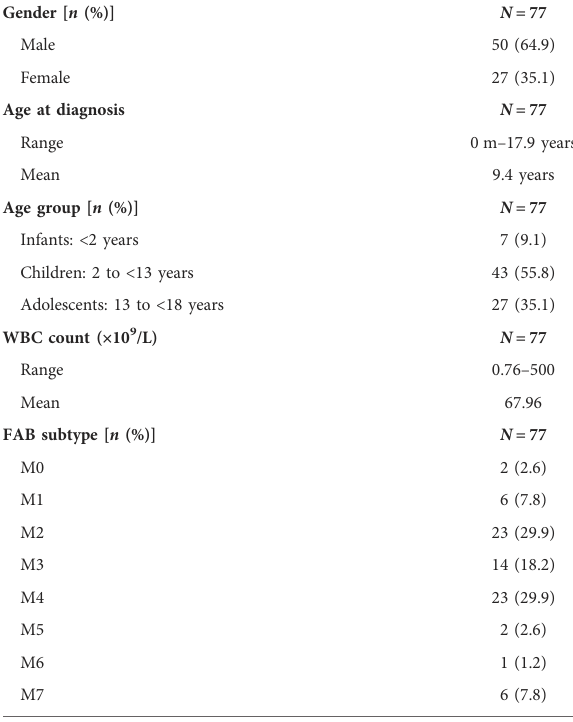
TABLE 1 Characteristics of pediatric patients diagnosed with AML and registered by the MIGICCL between 2019 and